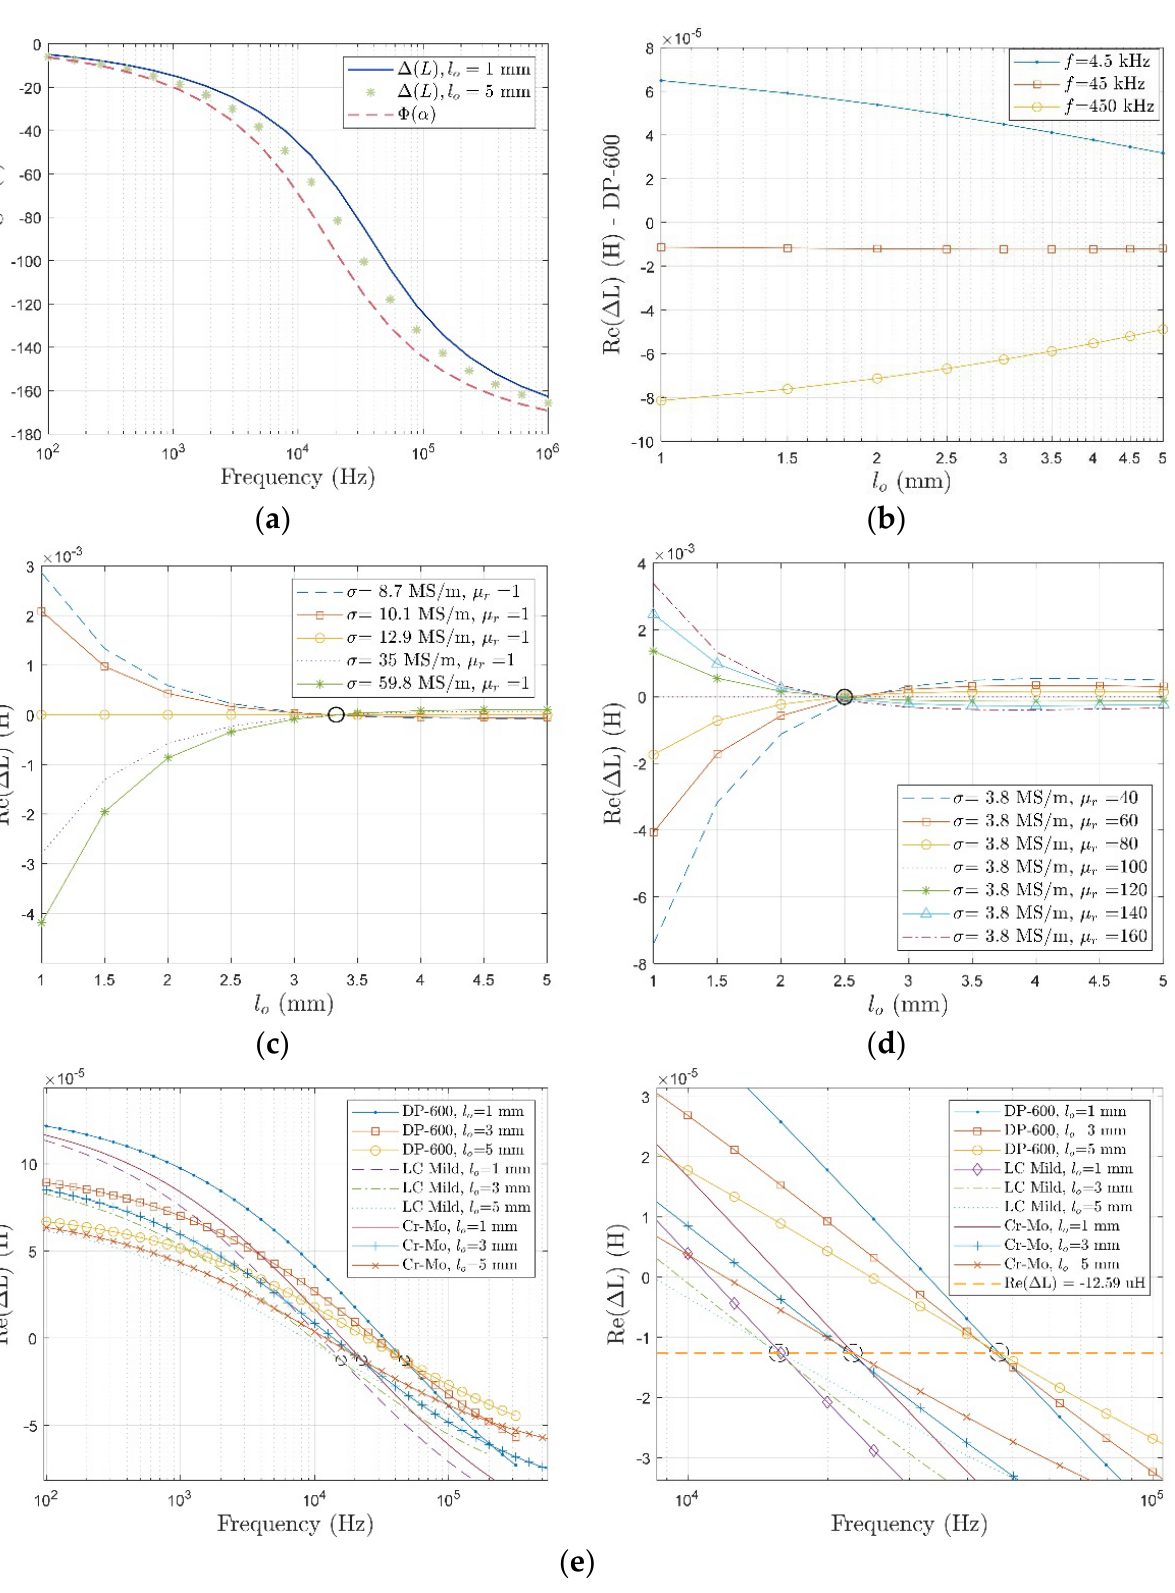
Figure 16. Lift-off invariance features: ( a ) Phase invariance phenomenon; ( b ) lift-off invariance inductance; ( c ) conductivity invariance phenomenon; ( d ) permeability invariance phenomenon; ( e ) lift-off invariance frequency.